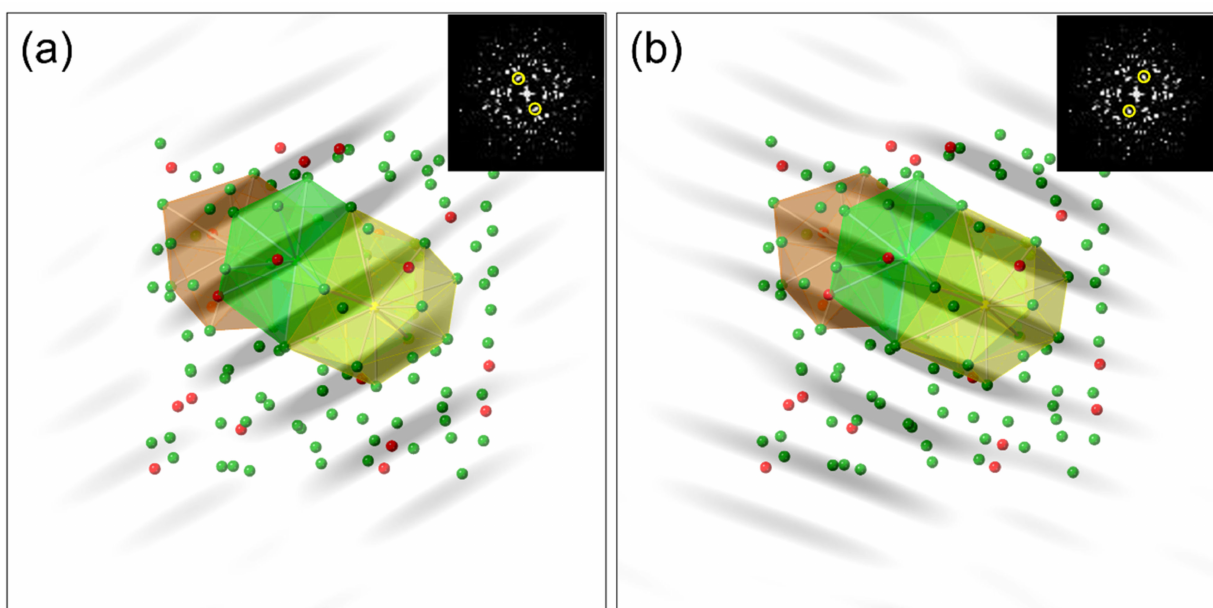
Figure 4. Inverse fast Fourier transform images obtained by paired spots in the fast Fourier transform patterns shown in the insets. The fast Fourier transform patterns are calculated from the black and white image of the atomic configuration in Figure 3b. The spots used in ( a , b ) are different from each other.